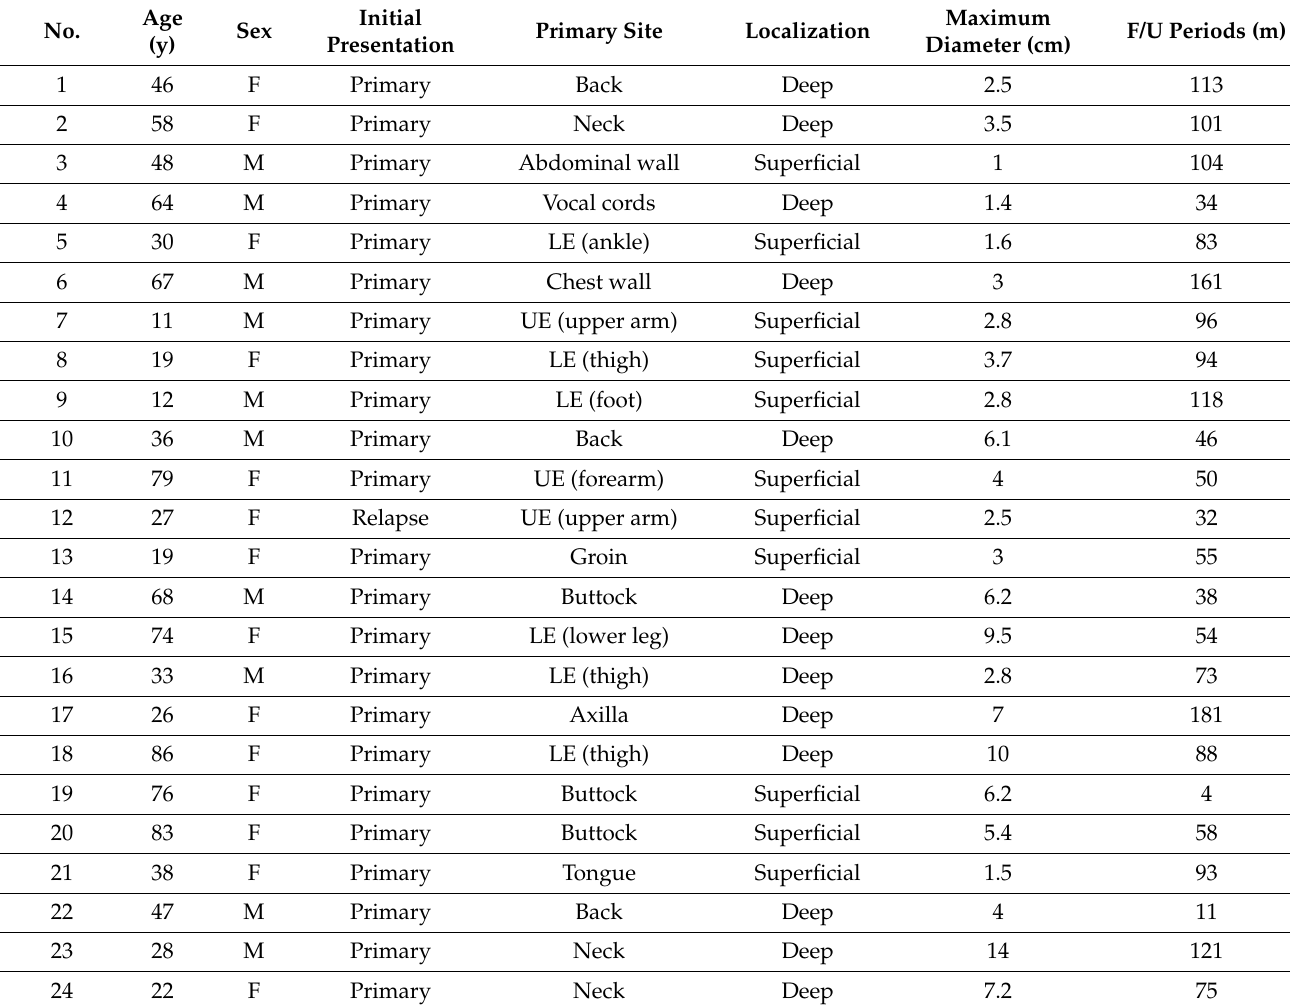
LE: lower extremities, UE: upper extremities, F/U: follow-up.